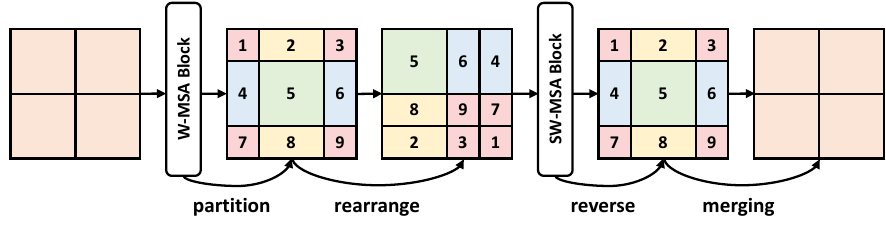
Figure 3. An illustration of the shifted window approach.